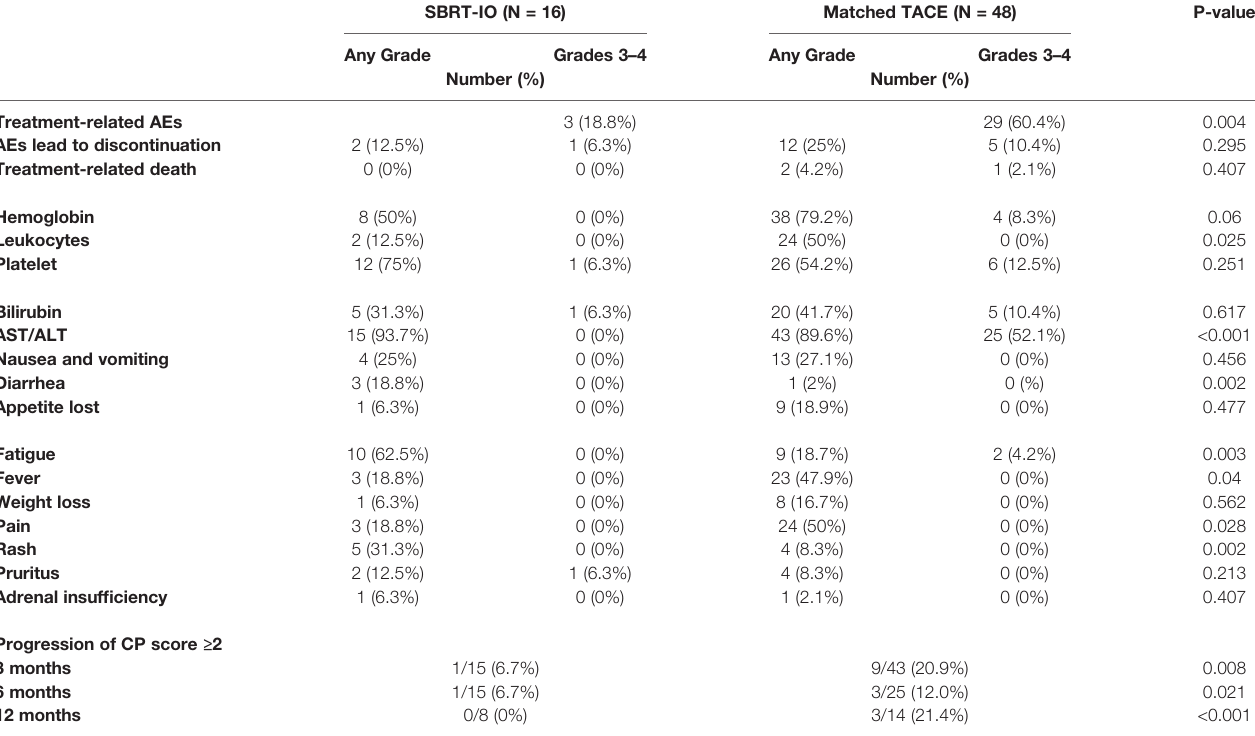
TABLE 3 | Treatment related adverse event and Child-Pugh score progression of SBRT-IO vs. matched